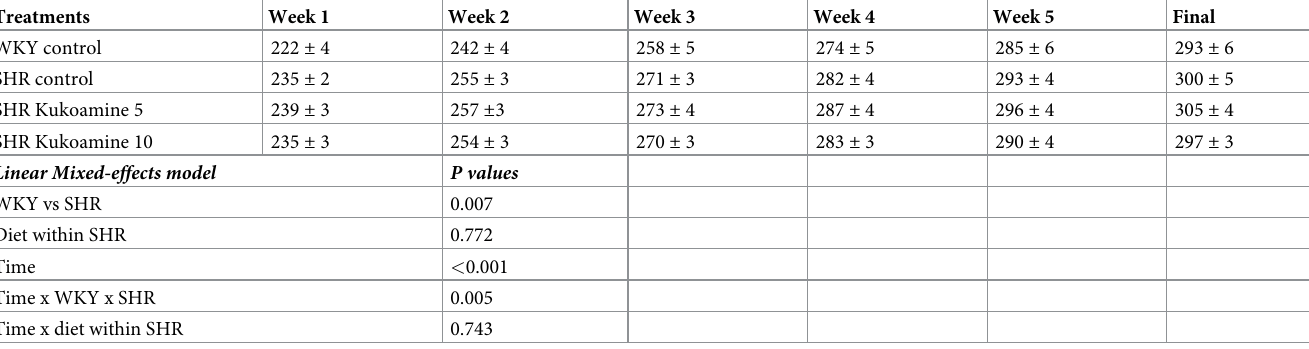
Table 6. Weekly mean arterial blood pressure (BP) (mm Hg) of the rats on the experimental treatments 1 .